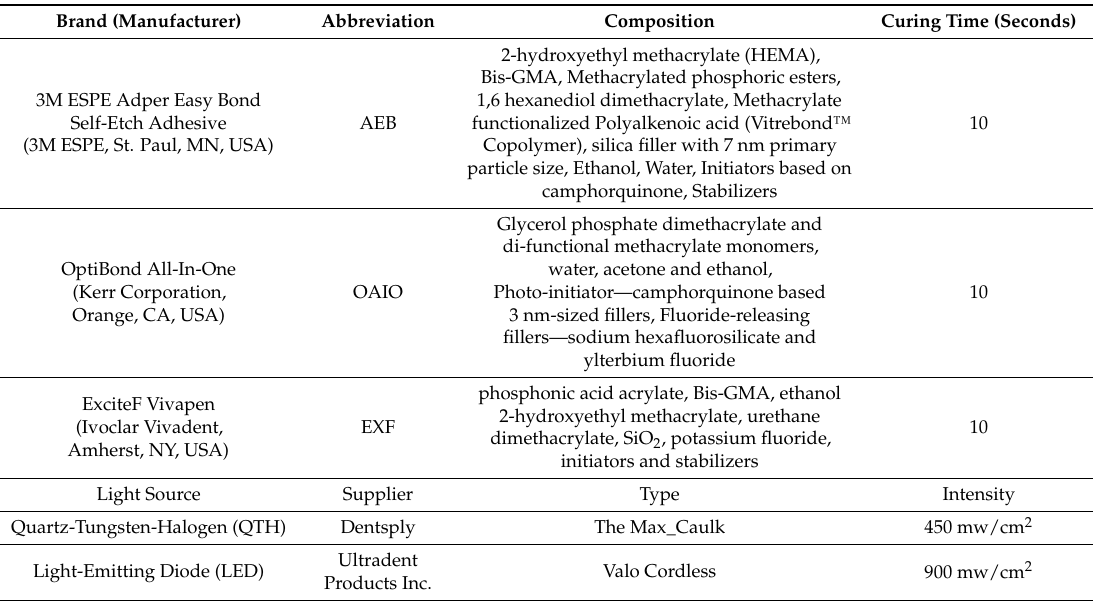
Table A1. Bonding adhesives and curing light units used.